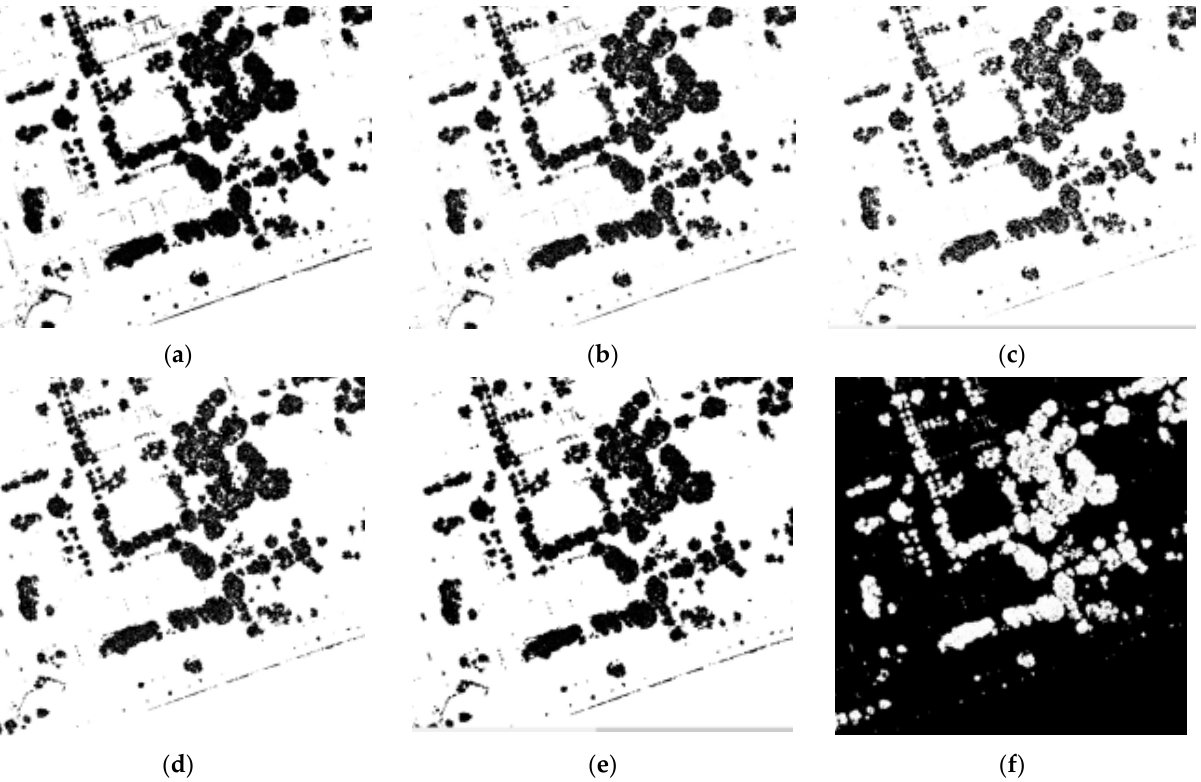
Figure 17. The binary raster obtained by applying the morphological operations erosion and dilation: ( a ) erosion, ( b ) dilation, ( c ) dilation, ( d ) erosion, ( e ) erosion, ( f ) vegetation mask.